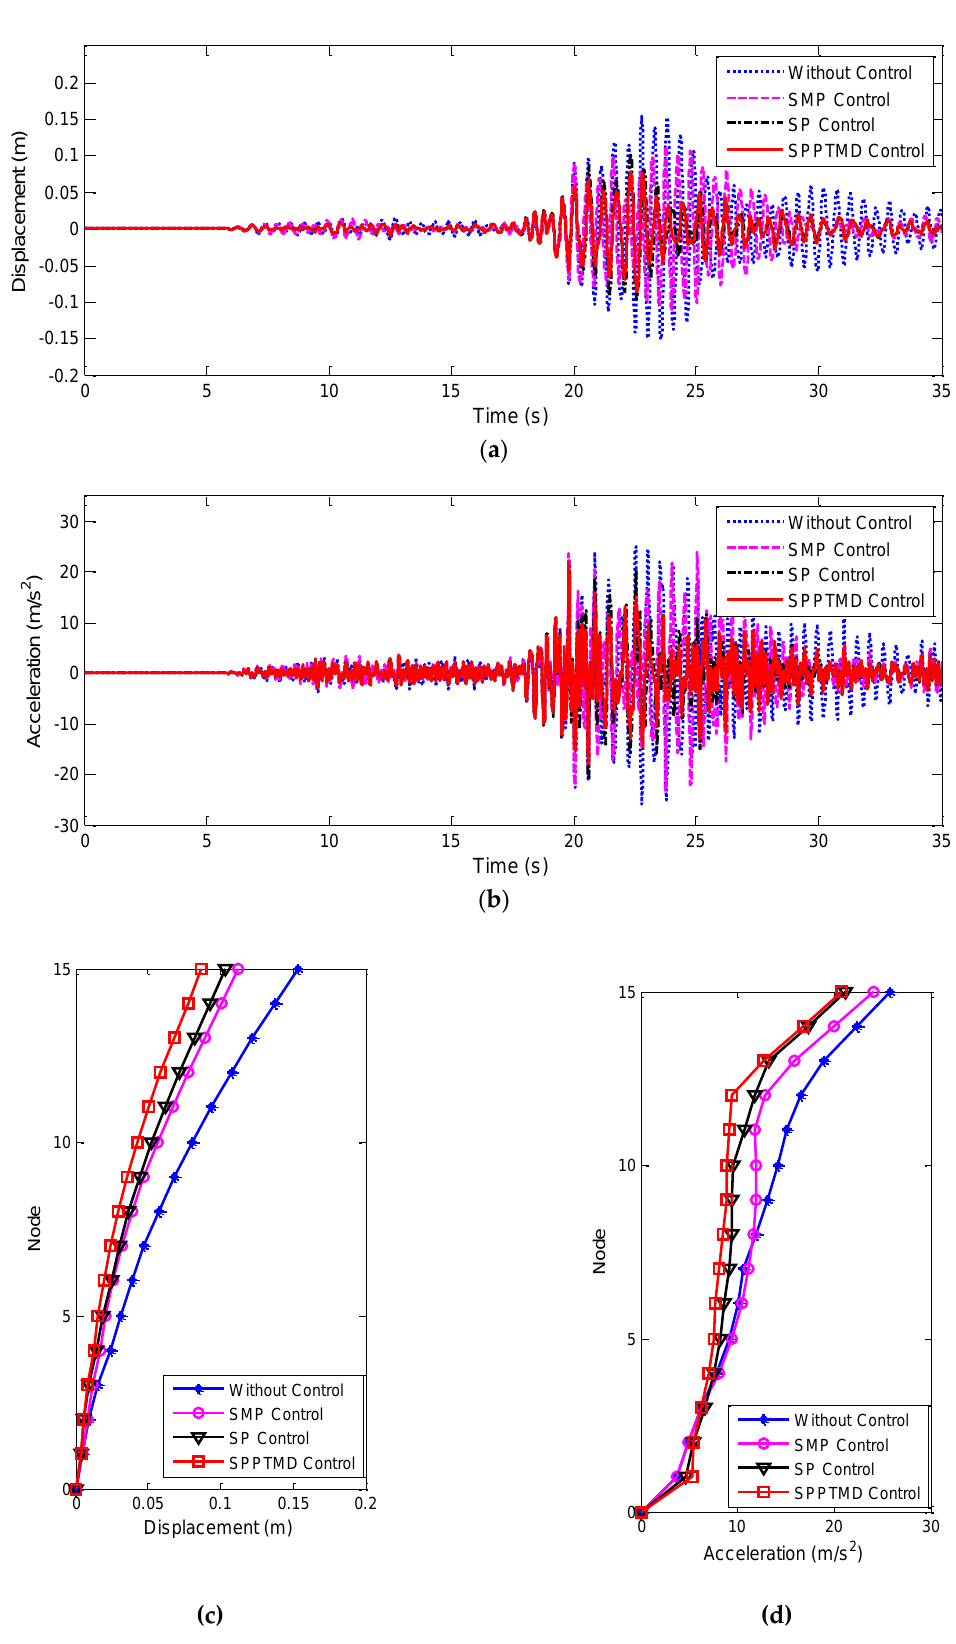
Figure 10. Seismic response of the tower top under EQ1: ( a ) displacement; ( b ) acceleration; ( c ) envelope of displacement; and ( d ) envelope of